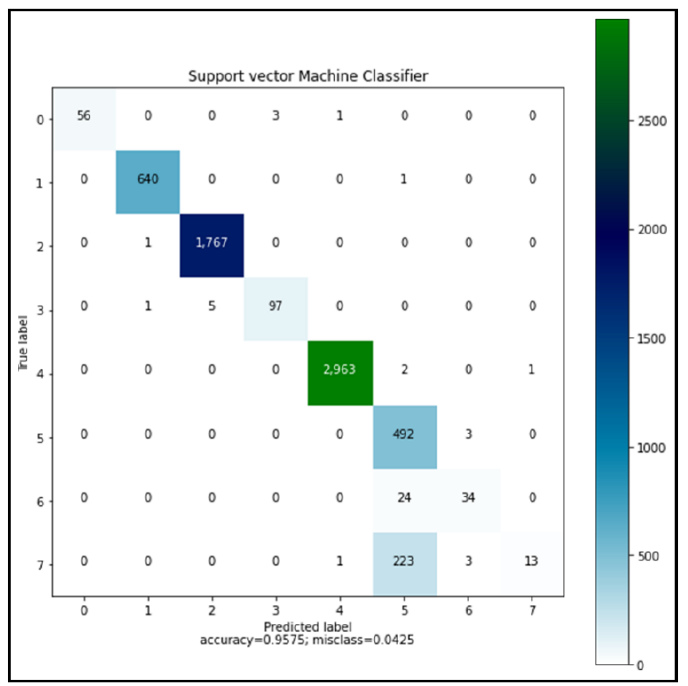
Figure 12. Confusion matrix for the support vector machine.